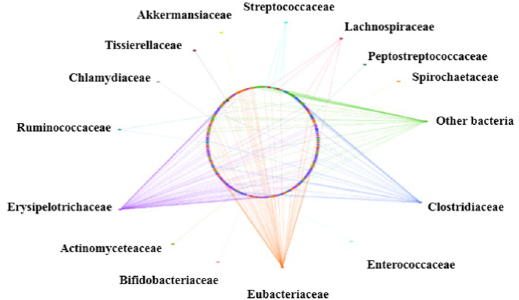
Figure 4. Network showing the origin of predicted protein-coding genes in strain Marseille-P3254 according to bacterial families. A total of 714 protein-coding genes were likely to be acquired vertically or from closely related species within the family Erysipelotrichaceae , and 1601 genes were likely to be gained by lateral gene transfer from members of other bacterial